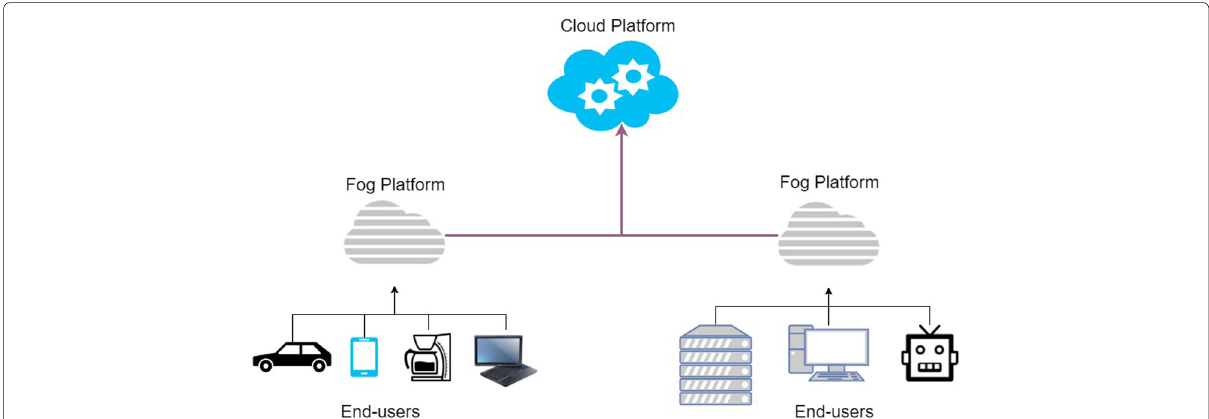
Fig. 1 Fog computing by Cisco. This figure shows how diverse set of devices can communicate with the Cloud using Fog computing